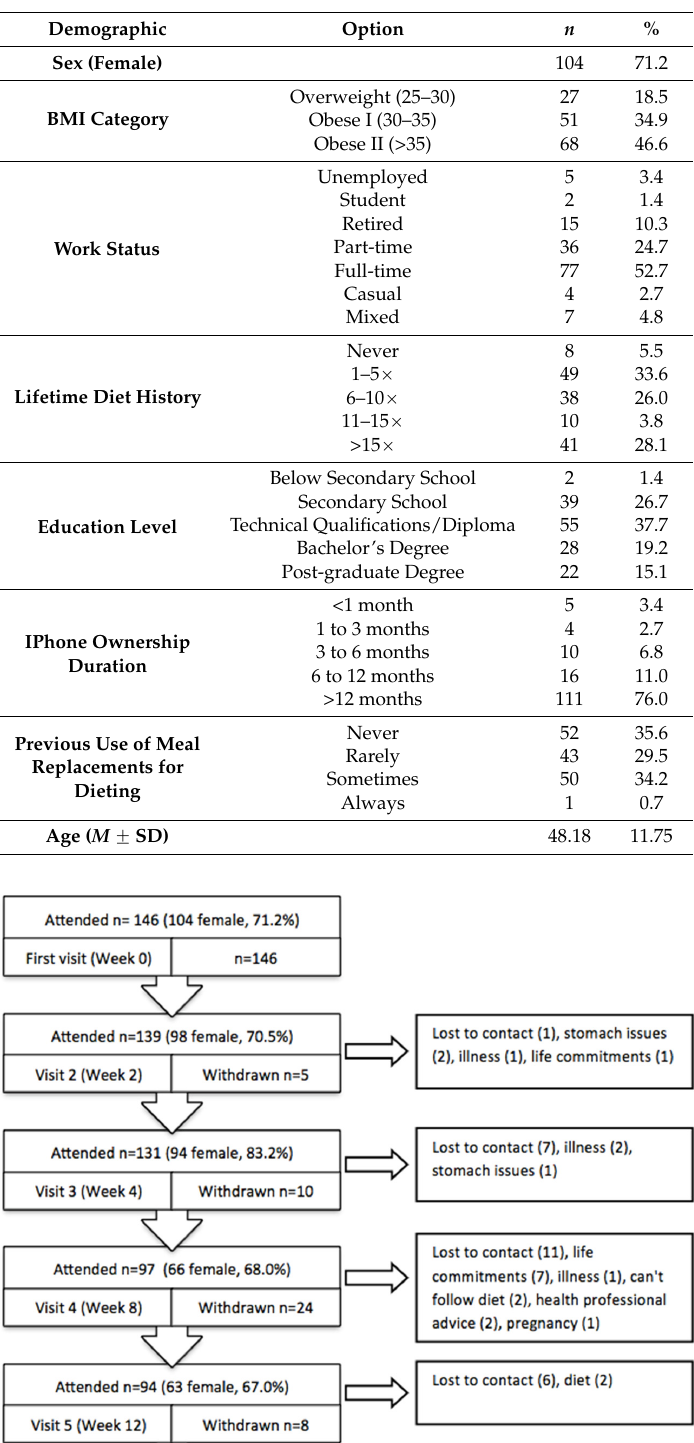
Table 1. Participant demographics for those starting the trial ( n = 146).